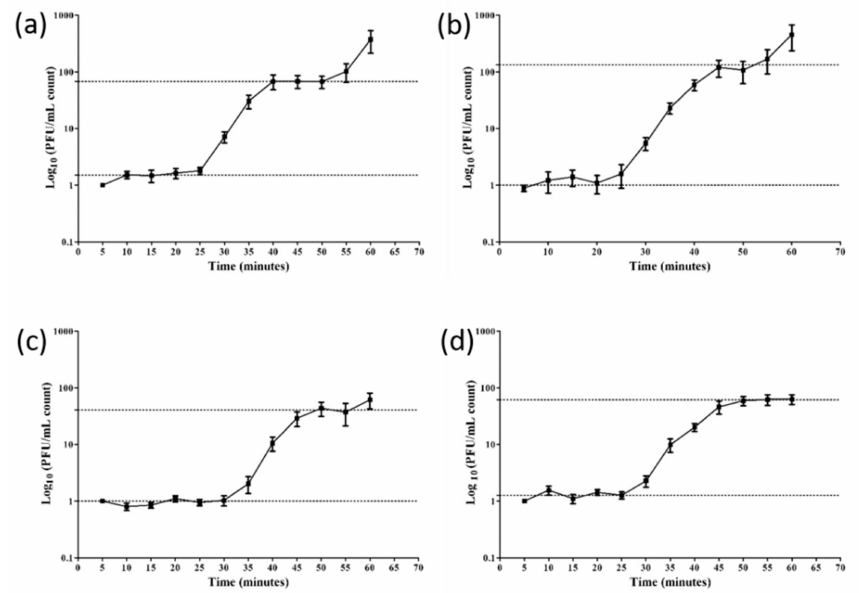
Figure 4. One step growth curves of phages Stab20 ( a ), Stab21 ( b ), Stab22 ( c ) and Stab23 ( d ) in S. xylosus DD-34 when incubated at 37 ◦ C. The average burst sizes were 66, 130, 42 and 62 for Stab20, Stab21, Stab22, and Stab23, respectively.